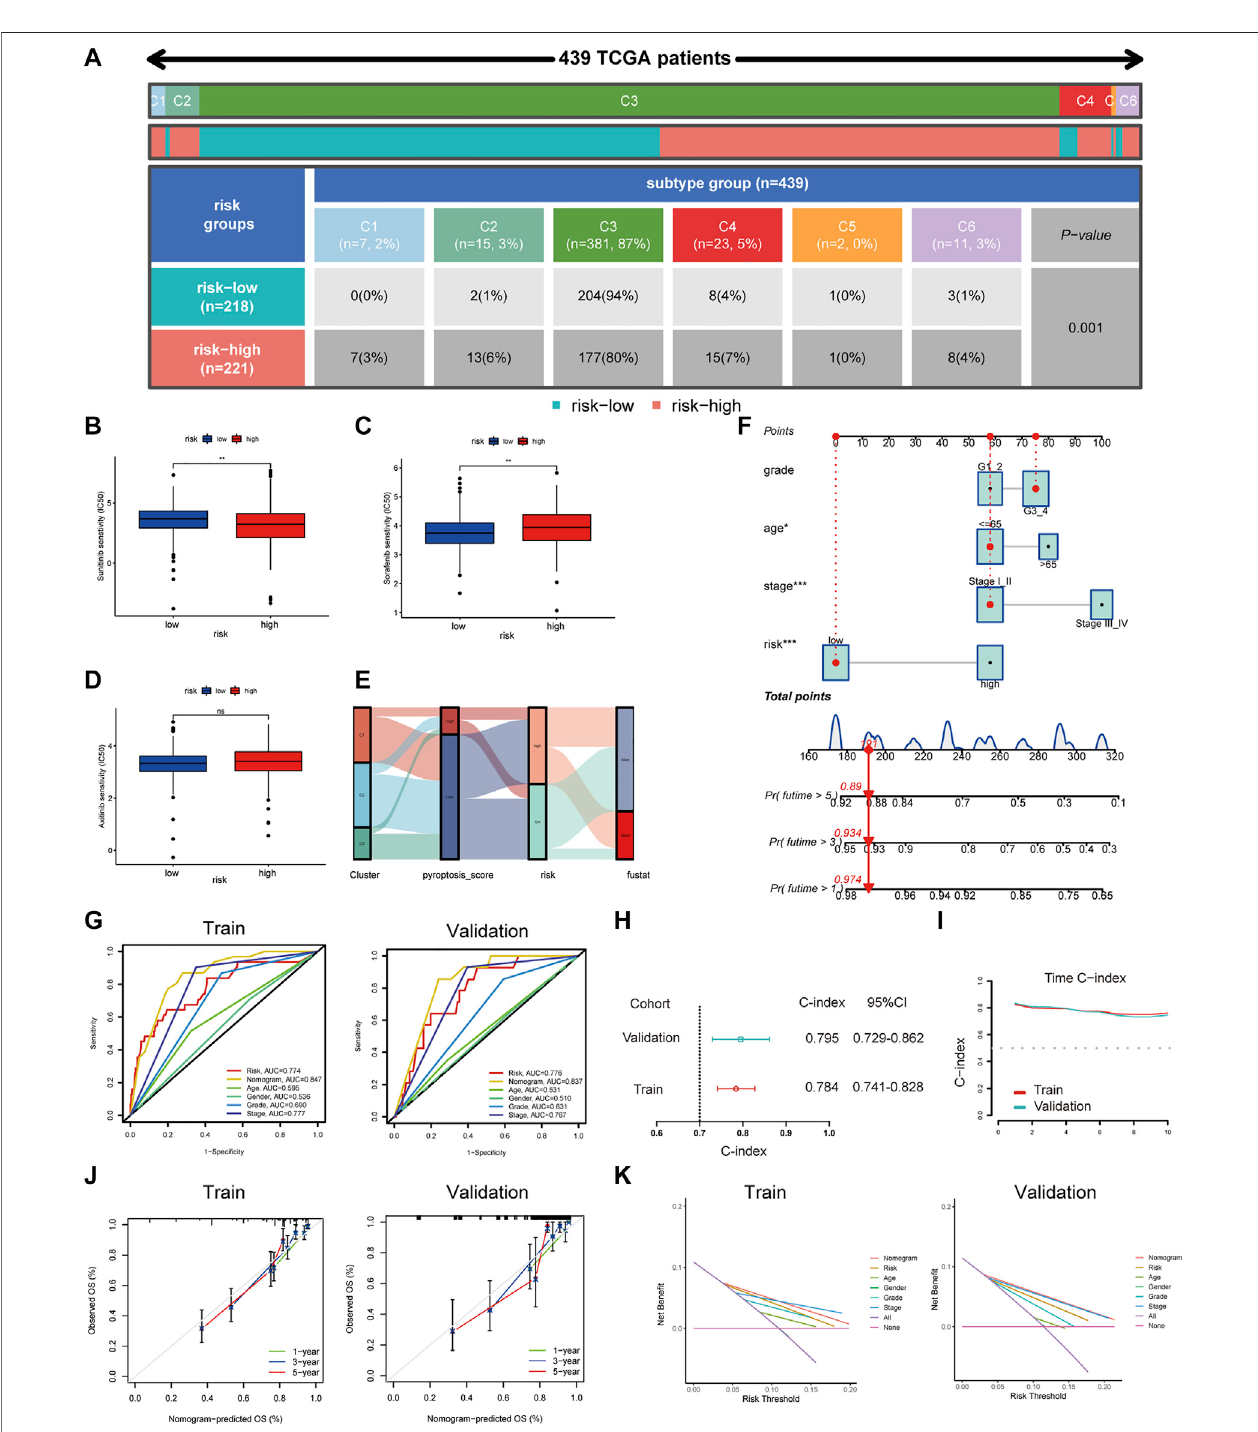
FIGURE 8 | Drug treatment response and nomogram construction and validation. (A) The distribution of six immune subtypes of patients in high- and low-risk groups. (B – D) Different IC50 of targeted drugs between the patients in high- and low-risk groups. (E) The alluvial diagram demonstrated the relationship between risk groupsbasedonriskScoreandmolecularsubtypes. (F) AnomogramcontainingclinicalfeaturesandtheriskgroupsbasedonriskScoretopredictsurvivaltime. (G) The receiver operating characteristic curve of nomogram and clinical features. (H) The C-index for exhibiting the ratio of the predicted result to the actual result. (I) The C-indextrendovertime. (J) ThecalibrationcurvewasusedtopredicttheOSofccRCCpatientsinthetrainingandvalidationcohorts. (K) TheNBassessingtheoutcome was illustrated by DCA.